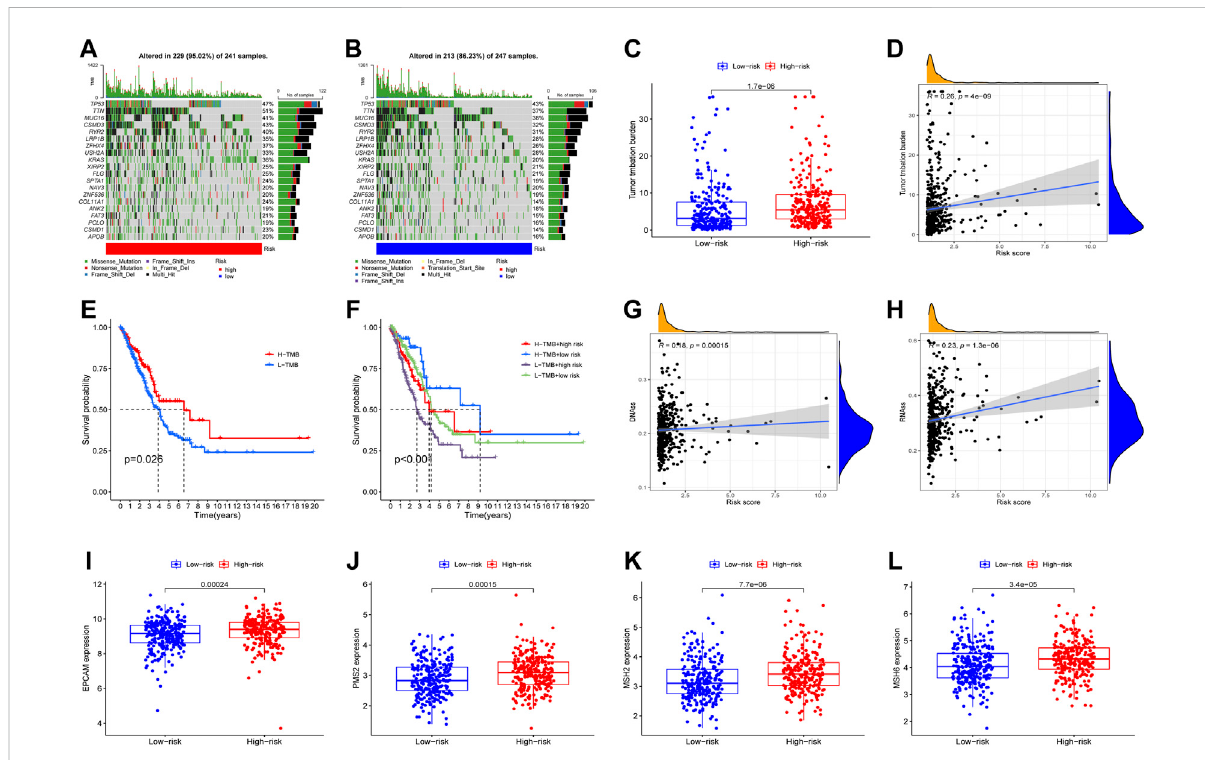
FIGURE 6 The relationship between risk score and mutation, tumor stemness, mismatch repair-related genes. Waterfall plots displayed the mutation informationoftop20geneswithhighmutationfrequencyinhigh-riskgroup (A) andlow-riskgroup (B) .ThedifferenceofTMBbetweenhigh-riskand low-risk groups (C) . The correlation of TMB and risk score (D) . Survival analysis of LUAD patients with different level of TMB and TMB combing with risk score (E,F) . The difference of tumor stemness index (RNAss and DNAss) between high-risk and low-risk groups (G,H) . The difference of mismatch repair-related genes expression between high-risk and low-risk groups (I – L)